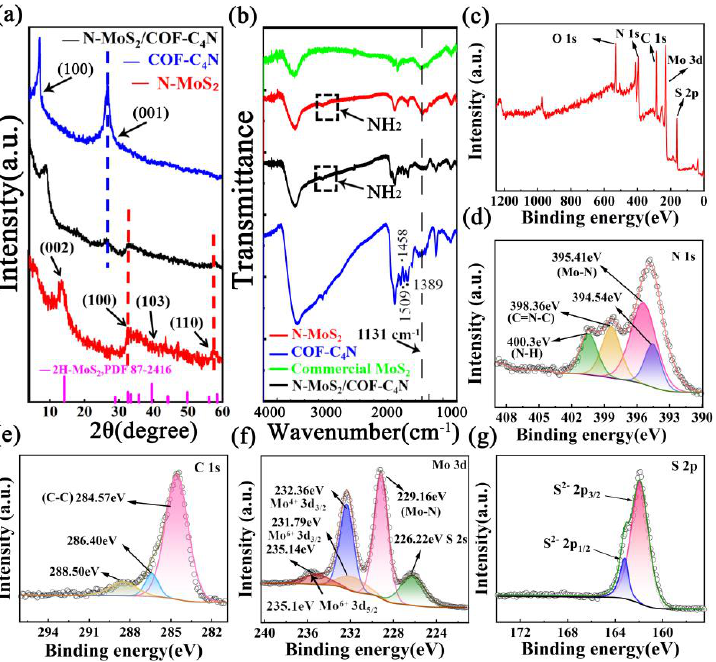
Figure 2. ( a ) XRD pattern of COF-C 4 N, vertical N-MoS 2 /COF-C 4 N, N-MoS 2 ; ( b ) FTIR spectra of commercial MoS 2 , N-MoS 2 , COF-C 4 N, and vertical N-MoS 2 /COF-C 4 N; XPS spectra of ( c ) XPS survey, ( d ) N 1s, ( e ) C 1s, ( f ) Mo 3d and ( g ) S 2p.